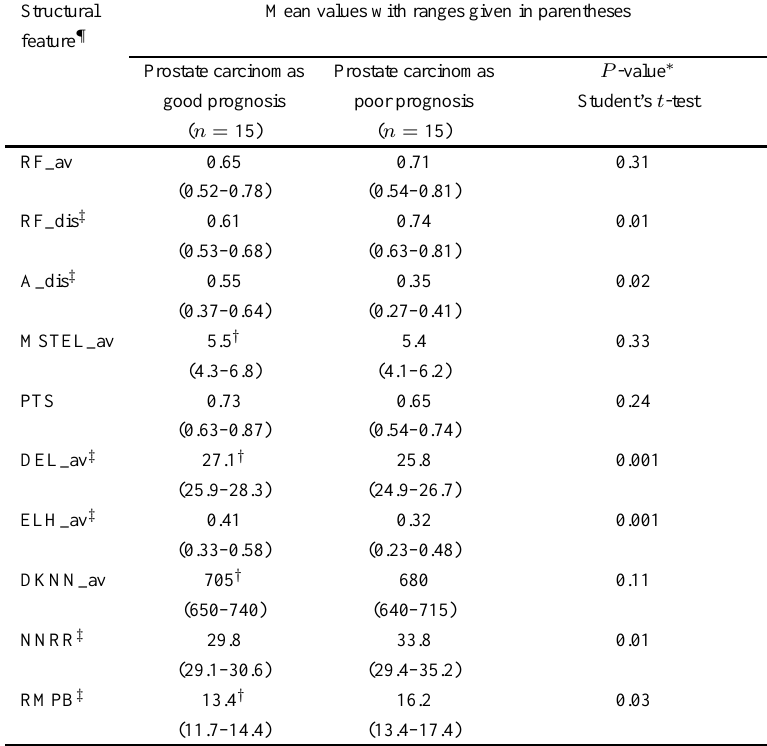
Prognostic value of 10 structural features in carcinomas of the prostate Structural Mean values with ranges given in parentheses feature { Prostate carcinomas Prostate carcinomas P -value (cid:3) good prognosis poor prognosis Student’s t